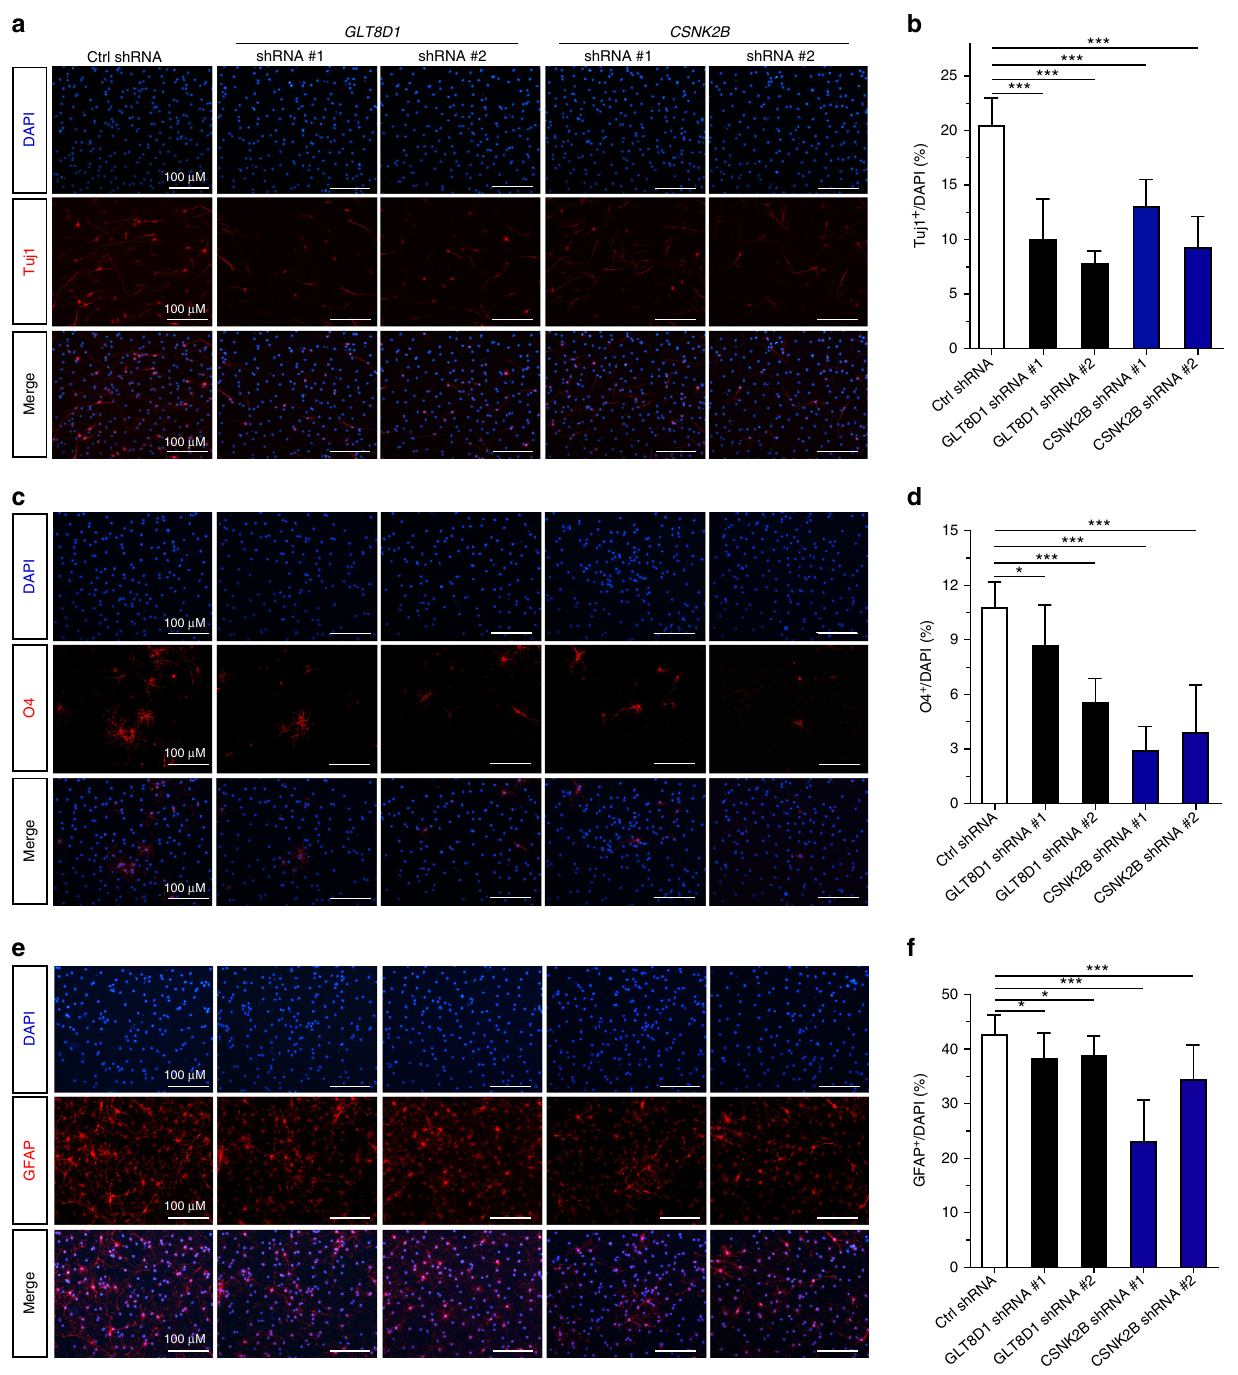
Fig. 4 Knockdown of GLT8D1 and CSNK2B inhibit the differentiation ability of NSCs. a , b Knockdown of GLT8D1 and CSNK2B inhibited the differentiation of NSCs into neurons. a Representative immunostainings for Tuj1 (a marker for newly generated immature neurons) in indicated cells. b The quanti fi cation data for a . c , d Knockdown of GLT8D1 and CSNK2B signi fi cantly inhibited the differentiation of NSCs into oligodendrocytes. c Representative immunostainings for O4 (a marker for oligodendrocytes) in indicated cells. d The quanti fi cation data for d . e , f Knockdown of GLT8D1 and CSNK2B inhibited the differentiation of NSCs into astrocytes signi fi cantly. e Representative immunostainings for GFAP (a marker for astrocytes) in indicated cells. f The quanti fi cation data for e . Scale bar: 100 µ M. * P < 0.05, ** P < 0.01, *** P < 0.001, two-tailed Student ’ s t -test. Data represent mean ± SD from three independent biological